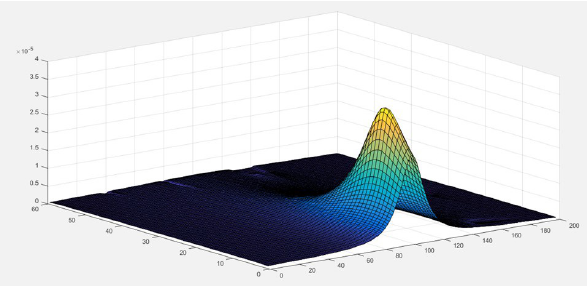
Fig. 13 Orphan radiation sources out of control in the